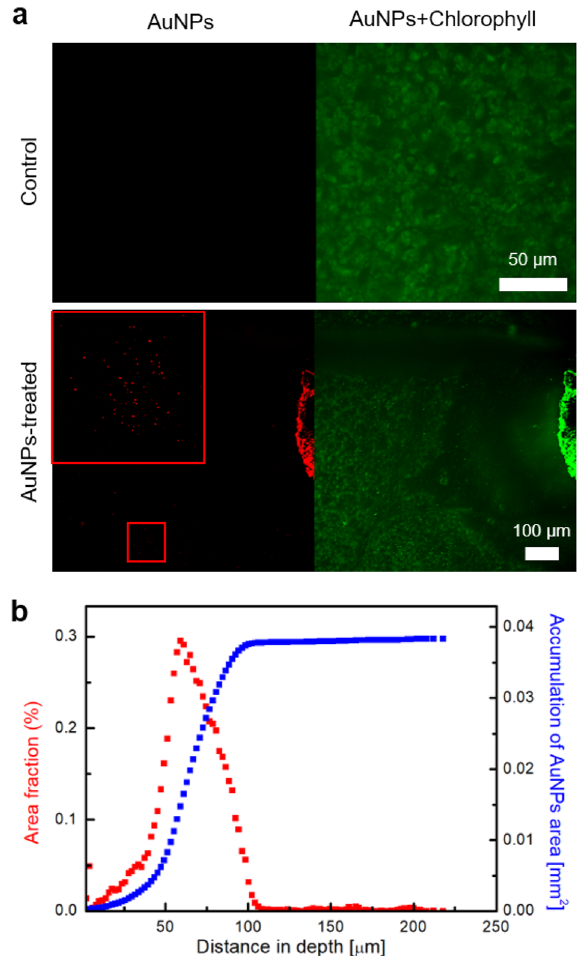
Figure 5. Spatial distributions of the infiltrated AuNPs in the region near the drop deposition point. ( a ) Projected images of the control and AuNP-treated P. frutescence leaves. The left images only show AuNPs, while the right images show AuNPs and chlorophylls. The edge indicates the region of drop deposition where saturation occurs. Inset in the red box shows a magnified image of the infiltrated AuNPs in plant tissues. ( b ) Variations in the area fraction (%) of AuNP fluorescence signals (red colors) and the accumulation of AuNP area (blue colors) along the depth